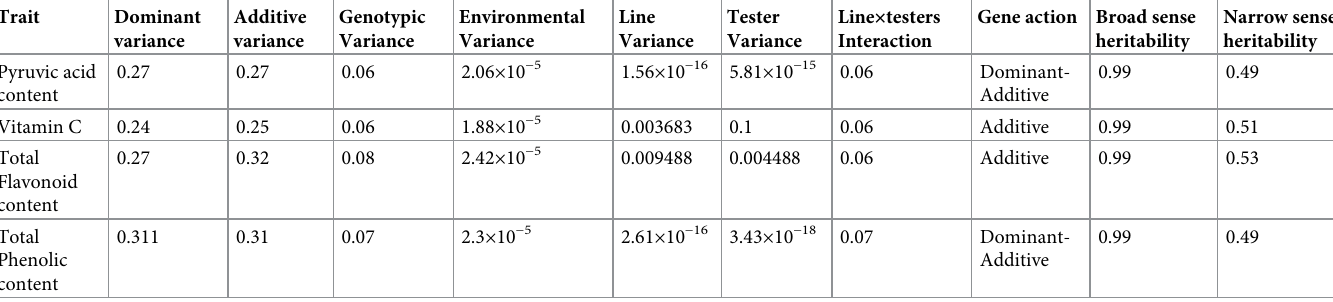
Table 6. Estimates of broad sense, narrow sense heritability and variance components for four nutraceutical traits.